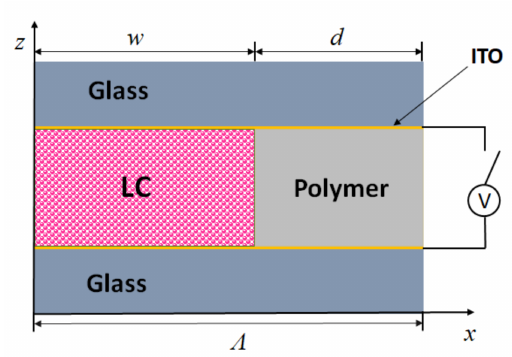
Figure 7. Schematic drawing of the cross-section of a unit cell used for RCWA calculations with the S 4